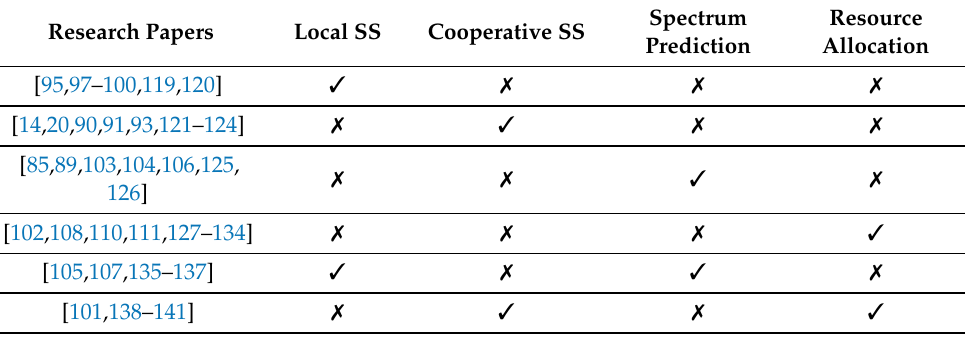
Table 4. Classification of recent papers that apply learning techniques in CR with respect to the covered topic. The mark (cid:51) (resp. (cid:55) ) means that the subject is covered (resp. is not covered) by the mentioned papers. Research Papers Local SS Cooperative SS